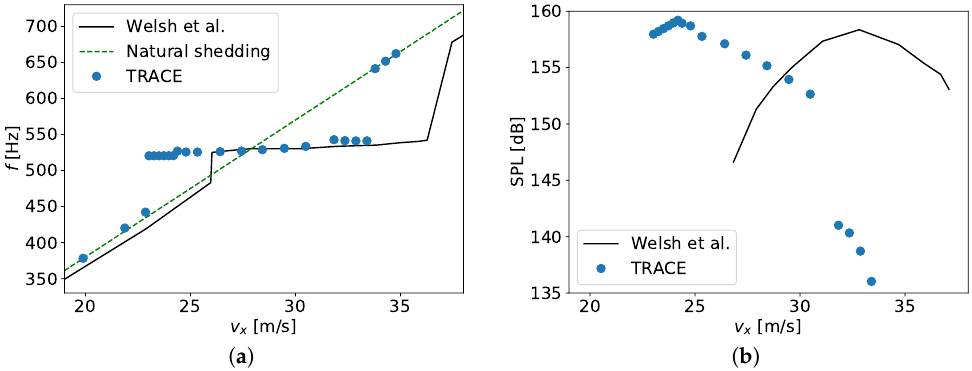
Figure 3. Comparison of numerical results to experimental findings by Welsh et al. [8]. ( a ) Vortex shedding frequency; ( b ) Sound pressure